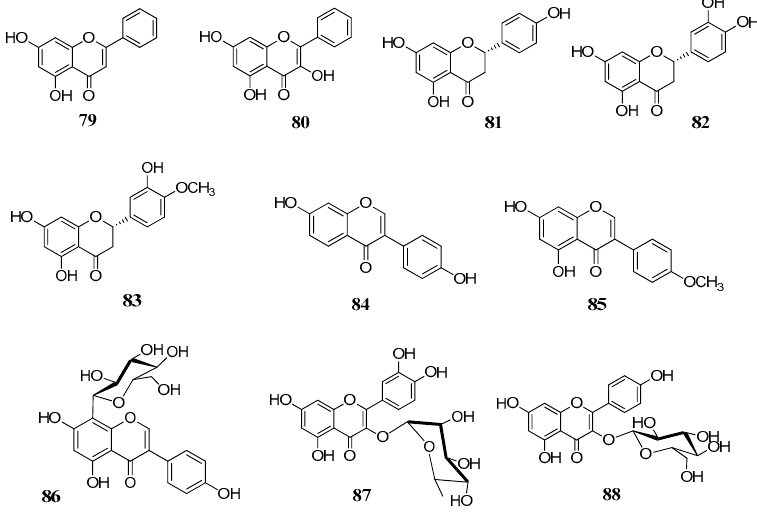
Figure 18. Structures of flavone 79 , flavonol 80 , flavanones 81 – 83 , isoflavones 84 , 85 , isoflavone glucoside 86 and flavonol glycosides 87 – 88 .